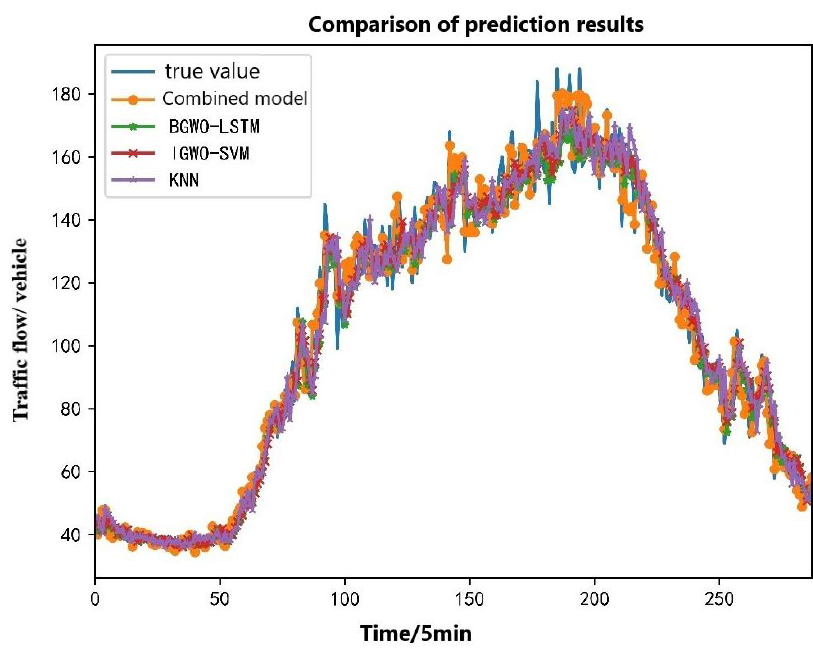
Figure 12. Comparison of multi-model prediction results.